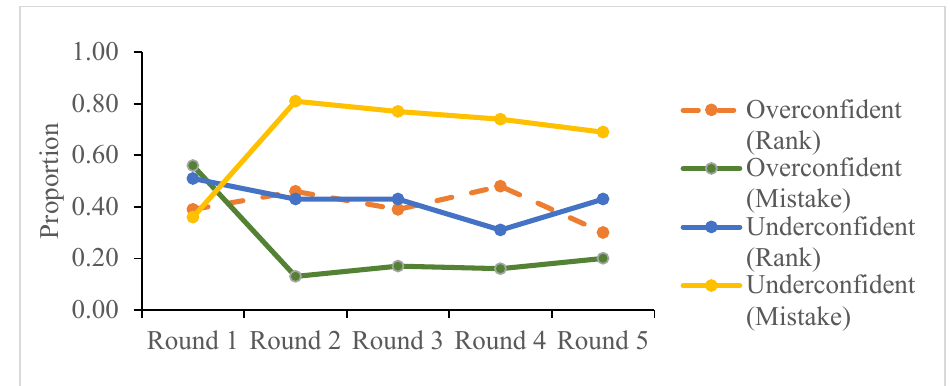
Figure 3. Proportion of Subjects with Overconfident and Underconfident Forecast. The proportion of subjects with overconfident (mistake) forecasts is significantly lower in Round 5 than in Round 1, with a p -value equal to 0.00 under the two-sample test of proportions. (The average correct rate (i.e., the correct number divided by the total number of words entered) in rounds 1, 2, 3, 4, and 5 are 0.66, 0.88, 0.87, 0.88, and 0.86, respectively. It seems that subjects became more conservative in their forecast on number of mistakes after seeing their first-round performance.) The proportion of subjects with overconfident (rank) forecasts is lower (weakly significant) in Round 5 than in Round 1, with a p -value equal to 0.06 under the two-sample test of proportions. This supports the idea that feedback can reduce the degree of overconfidence. Conversely, there is no sig- nificant difference between the proportions of subjects with underconfident (rank) fore- casts in Rounds 1 and 5, whereas the proportion for underconfident (mistake) forecasts in Round 5 is significantly higher than in Round 1, with a p -value equal to 0.00 under the two-sample test of proportions. Table 2. Proportion of Subjects with Overconfident/Underconfident Forecasts. Forecast